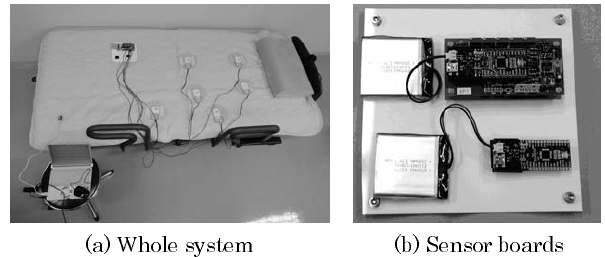
Figure 4. Photographs of our experimental environment, micropro- cessor board, and monitoring tool.